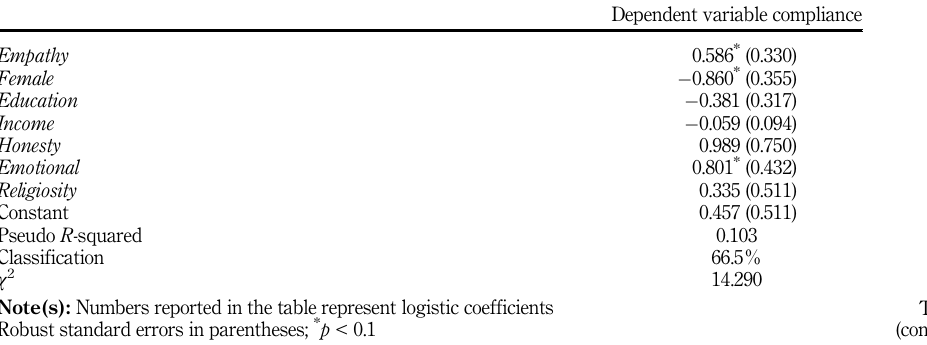
Table 3. Treatment